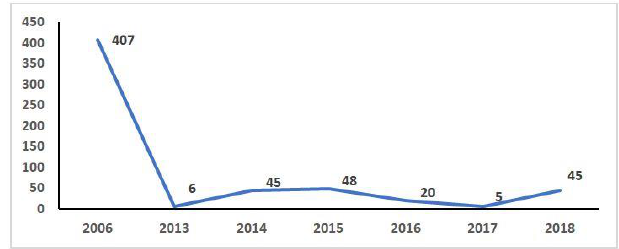
Fig. 1: LSD notifications in Egypt during